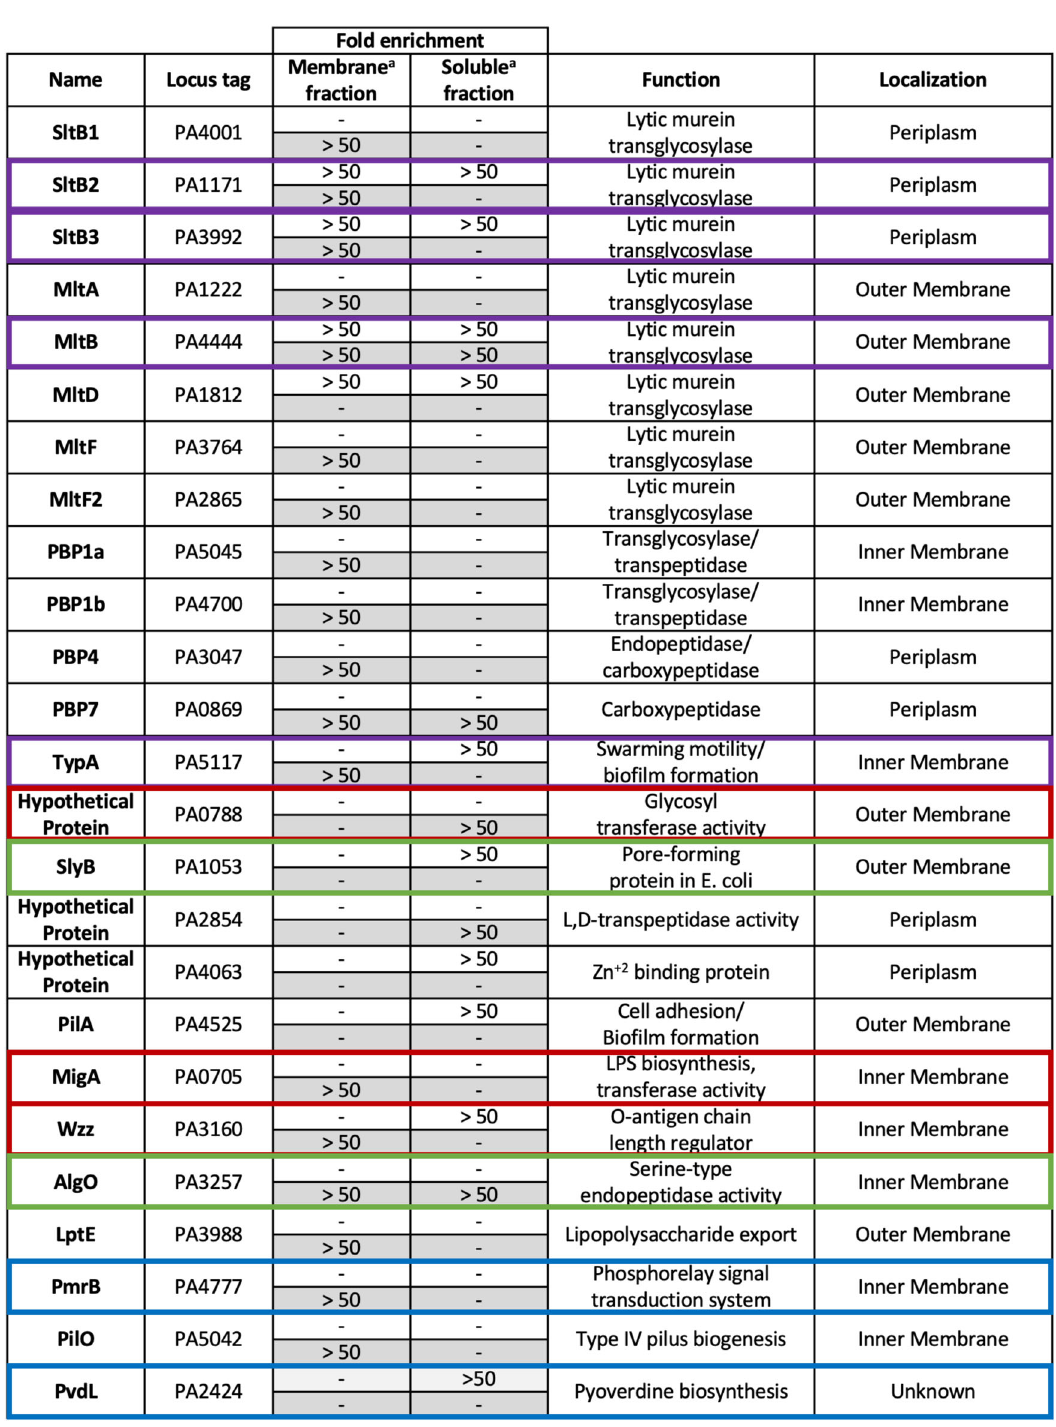
Fig. 5 RlpA-dependent pulldown enrichment of putative partner proteins. a Fold-enrichment of putative protein partners are calculated as the ratio of spectral count intensity of each run, compared to control (without RlpA- Δ 32). A dash indicates no enrichment. Unhighlighted cells (white background) signify the experiment with a crosslinker, and highlighted cells (gray background) indicate the result without a crosslinker. Entries boxed in red indicate proteins that aggregated on the expression of the genes, those in blue were not studied, and those in green were non-direct interactors by MST (SlyB showed interactions with RlpA- Δ 32 by SPR, which could not be quanti fi ed). All localization entries, regardless of classi fi cation, reside in the periplasmic milieu. Periplasm denotes protein that resides in the milieu and is soluble. The outer membrane denotes protein that is bound to the inner lea fl et of the outer membrane. The inner membrane denotes protein that is bound to the outer lea fl et of the inner membrane. Localizations and functions were collected from the Pseudomonas Genome Database (Cystic Fibrosis Foundation, Therapeutics). The oligomeric states of three proteins of Fig. 5 are known: SltB1 homodimer ( P. aeruginosa ), MltA homodimer ( Acinetobacter baumannii ), PBP1a homodimer ( Streptococcus pneumoniae ), PBP1b homodimer ( E. coli ), PilO homodimer ( P. aeruginosa ). The molecular weights of these proteins are listed in Supplementary Table